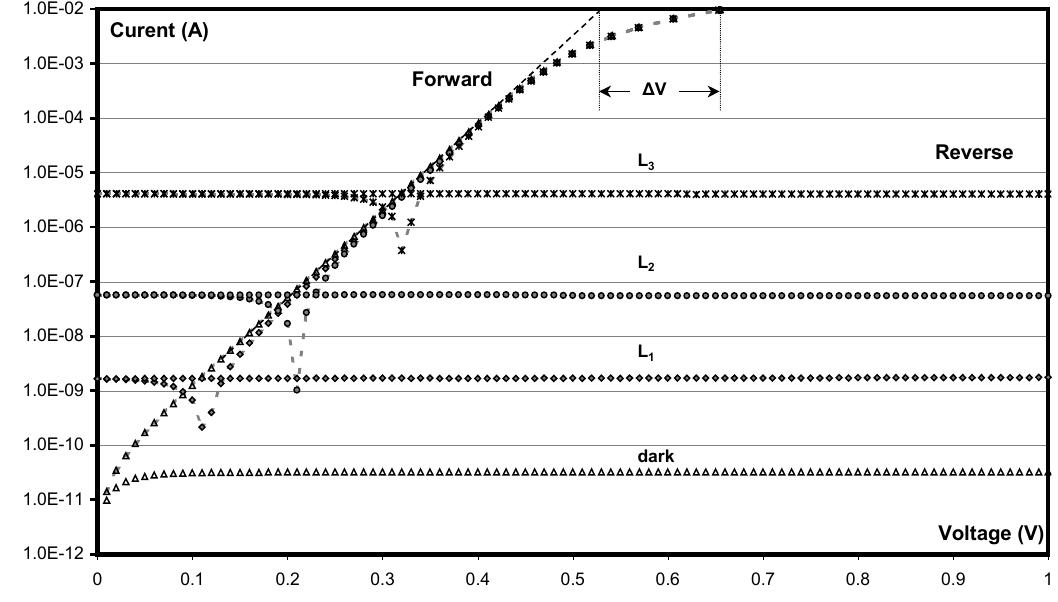
Figure 5. Theoretically evaluated I-V curves at various illumination levels (i.e., dark, L , L ) for a p-n junction having the following parametric data: I L 2 3 R = 12.94 Ω . The substituted reverse bias photocurrent values were: I s (L ) = 5.52 x 10 -8 A, and I A, I opt 2 experimentally obtained curves of Fig.